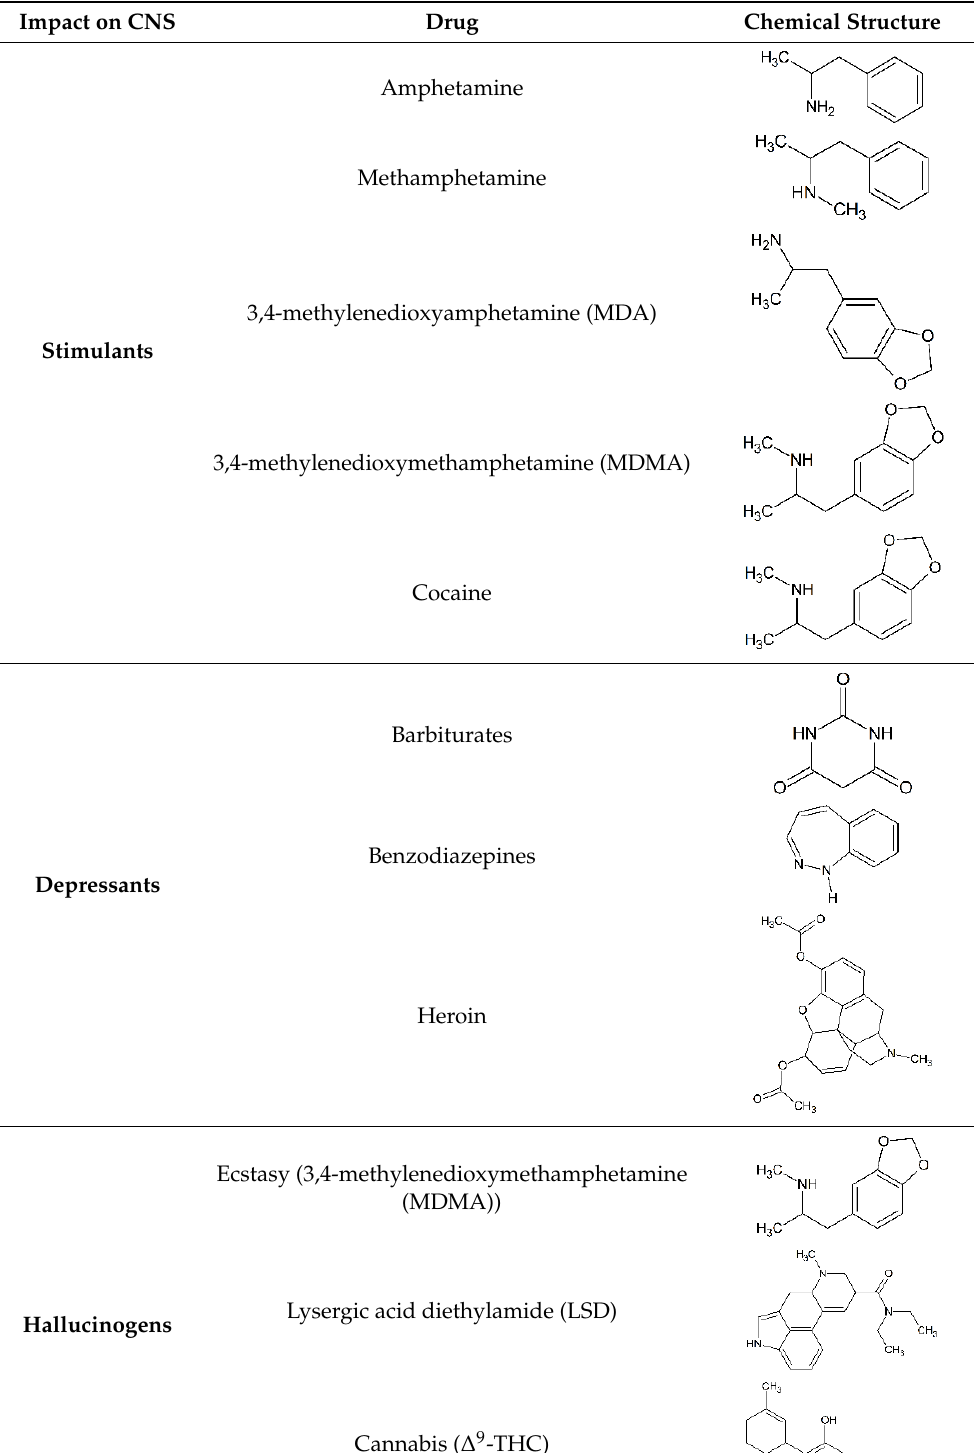
Table 1. Classification of common illicit drugs based on their mechanism of action on the CNS.